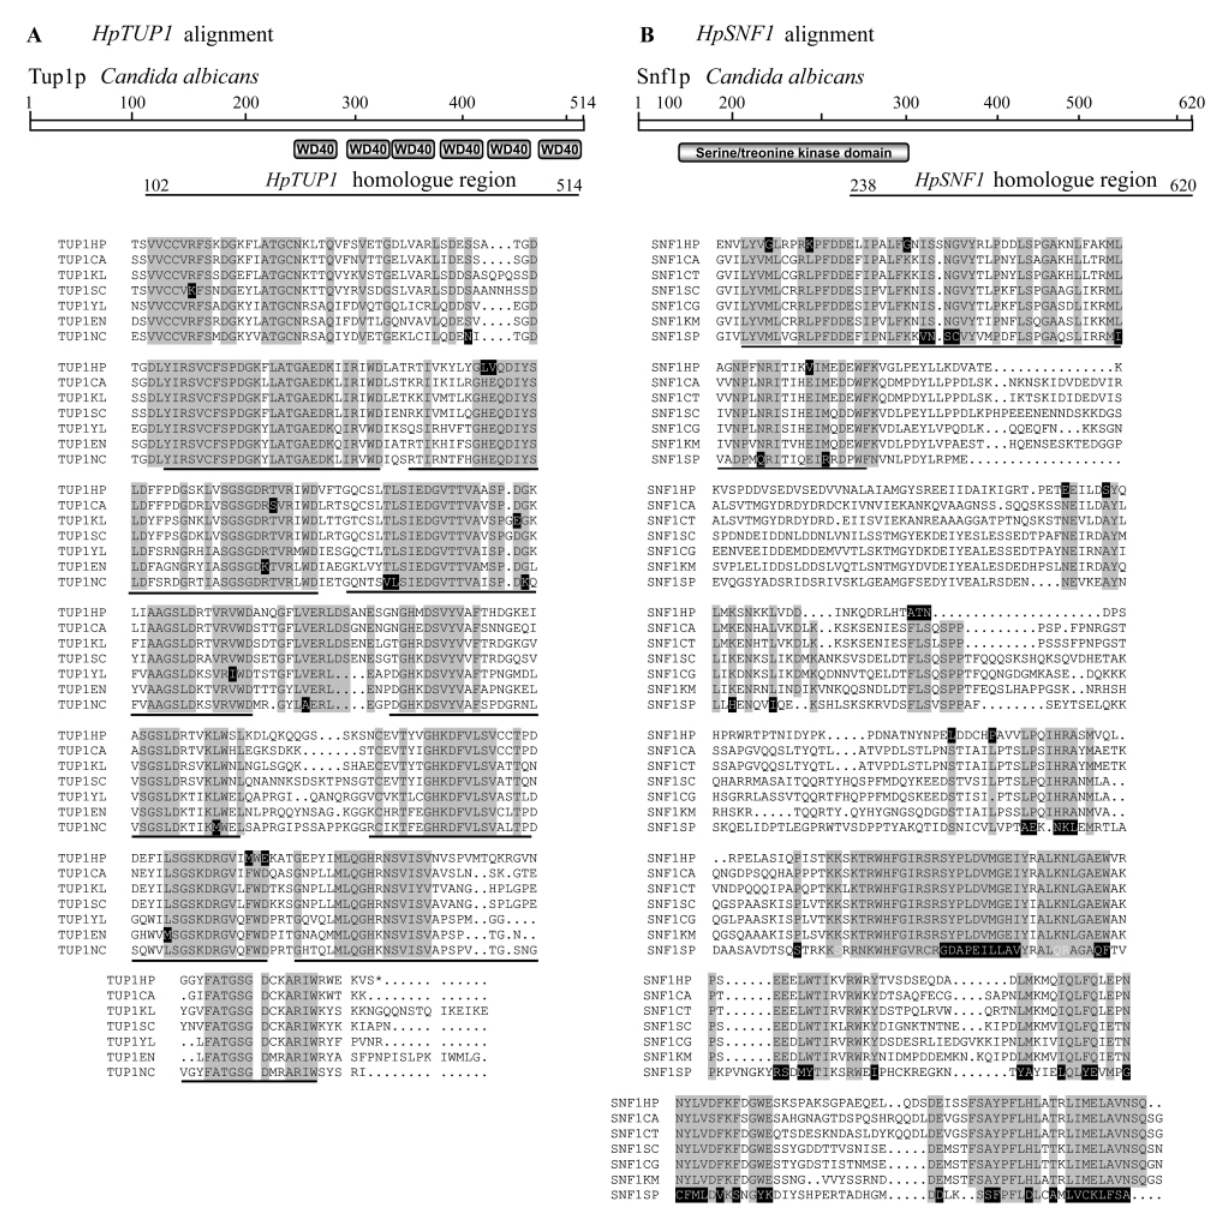
Figure 1 - Identification of Hp TUP1 and Hp SNF1 gene fragments. Alignments of the predicted HpTup1p (A) and HpSnf1p (B) proteins with other known homologs: HP - Hansenula polymorpha , CA - Candida albicans , CG - Candida glabrata , CT - Candida tropicalis , EM - Emericella nidulans , KL - Kluyveromyces lactis , NC - Neurospora crassa , SC - Saccharomyces cerevisiae , SP - Schizosaccharomyces pombe , YL - Yarrowia lipolytica . The known conserved domains identified in C. albicans proteins are schematically shown on top of the alignments (see text for details). Black boxes: single differencesbetweenspecies;grayboxes:highlyconservedregions;underlinedaminoacids:essentialfunctionaldomains.Alignmentsweredonewiththe Multalin tool (www.prodes.toulouse.inra.fr/multalin/multalin.html), and the DNA sequences were deposited in the NCBI GenBank with the